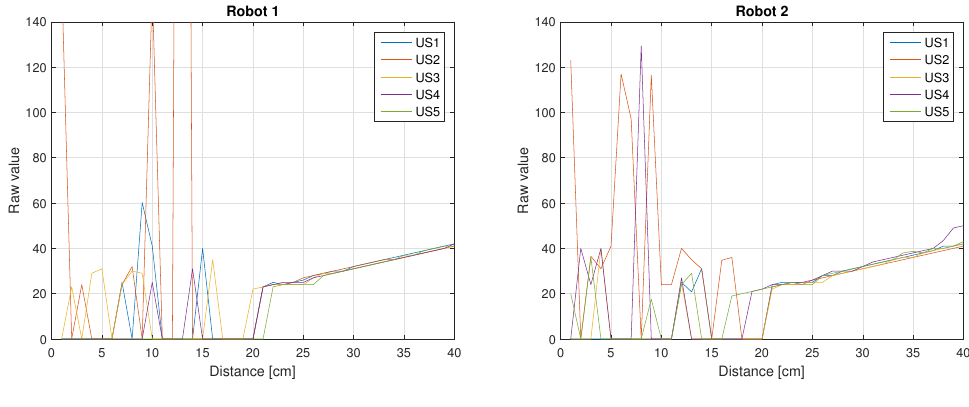
Figure 5. Robots 1 and 2 US sensors.